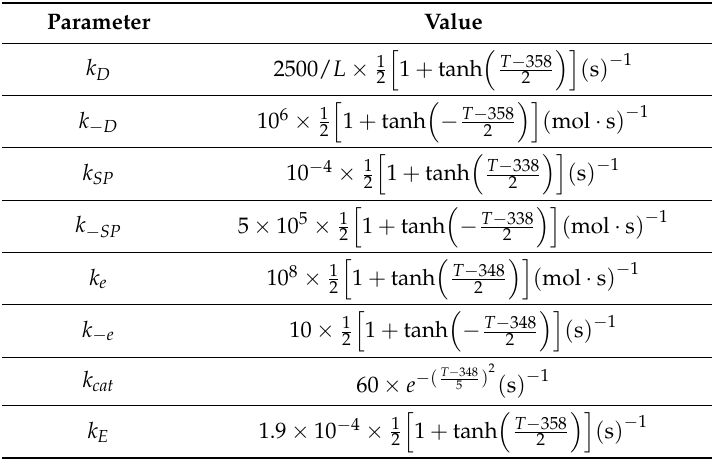
Table 1. Reaction parameters in the kinetic